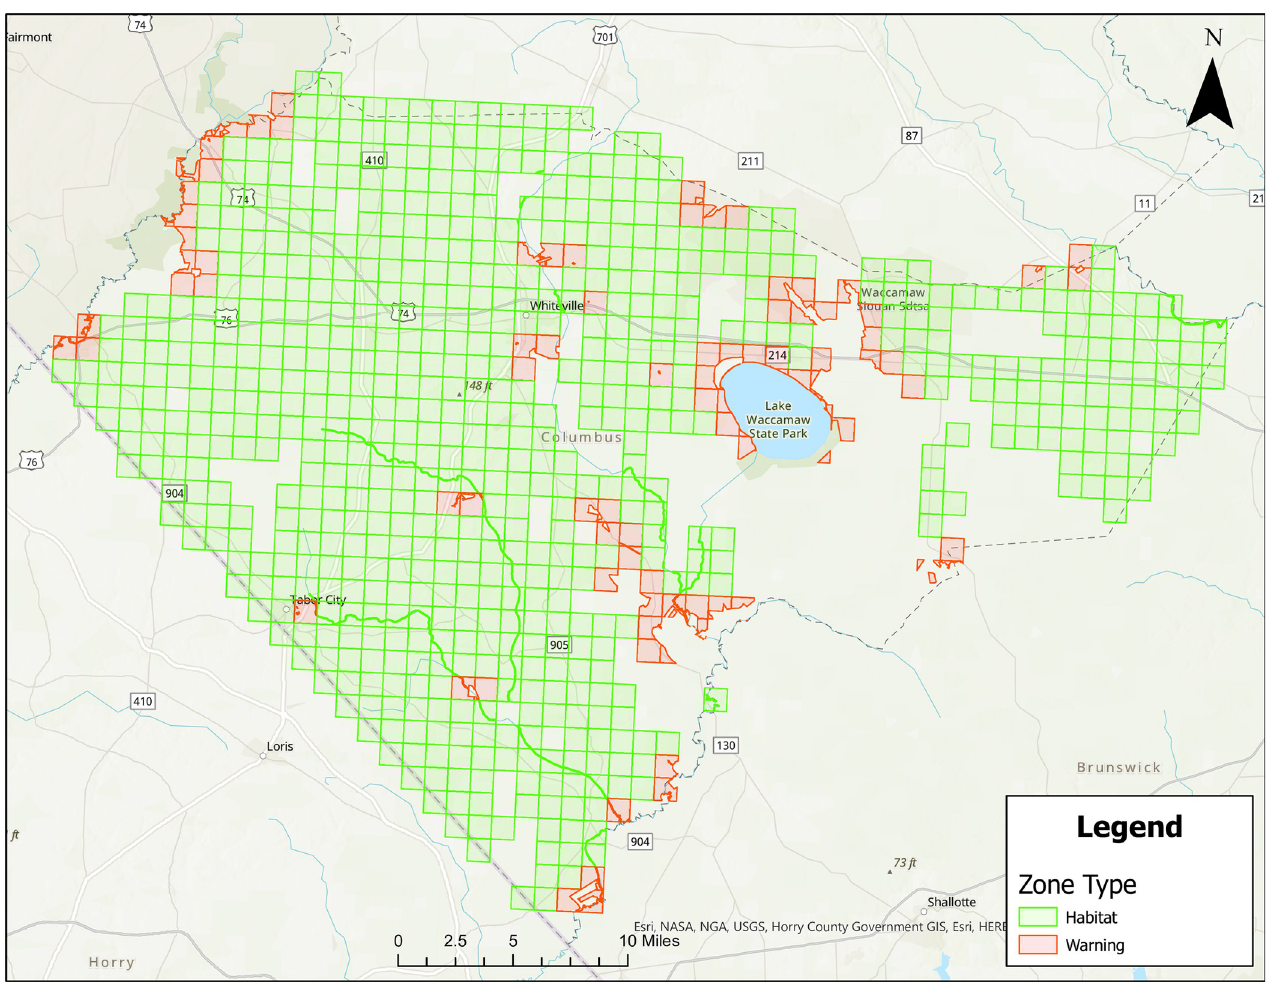
Fig 2. Areas in Columbus County, North Carolina for treatment consideration classified as approved (green) or warning (red). Maps do not consider human population density. Source files for maps (NC OneMap: Address, county, rivers, water bodies provided as S2 and S3 Files. Written release agreements to authorize use of geospatial data found on the NC OneMap website are not required.